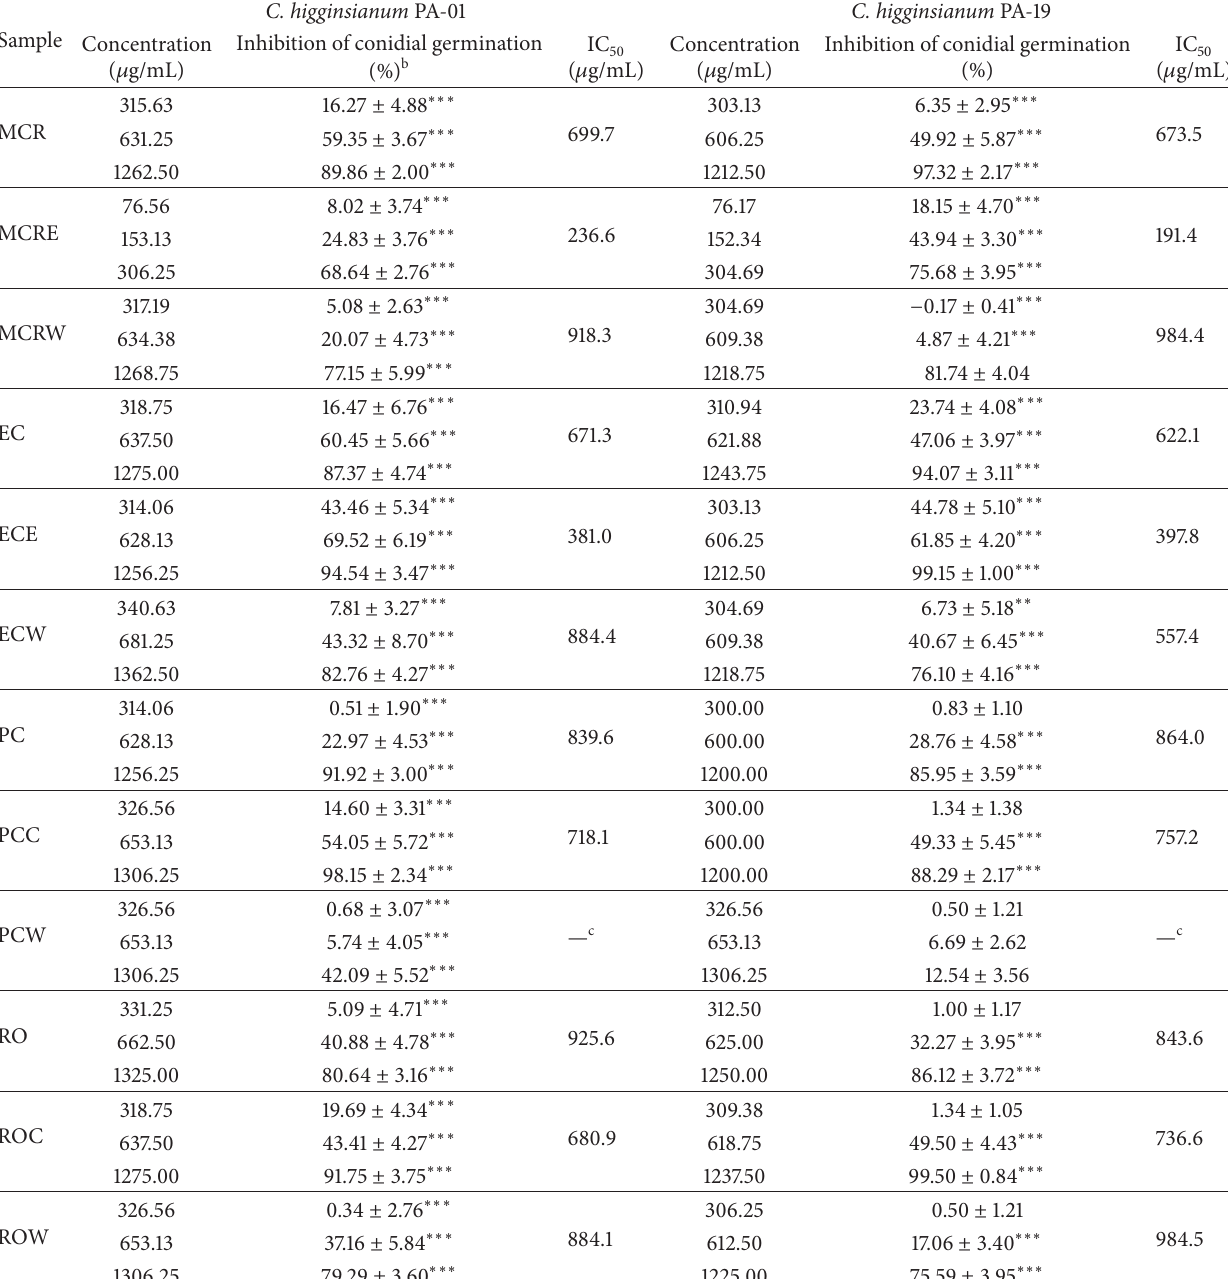
Table 4: Antifungal activity of crude extracts and fractions of Chinese medicinal herbs a .